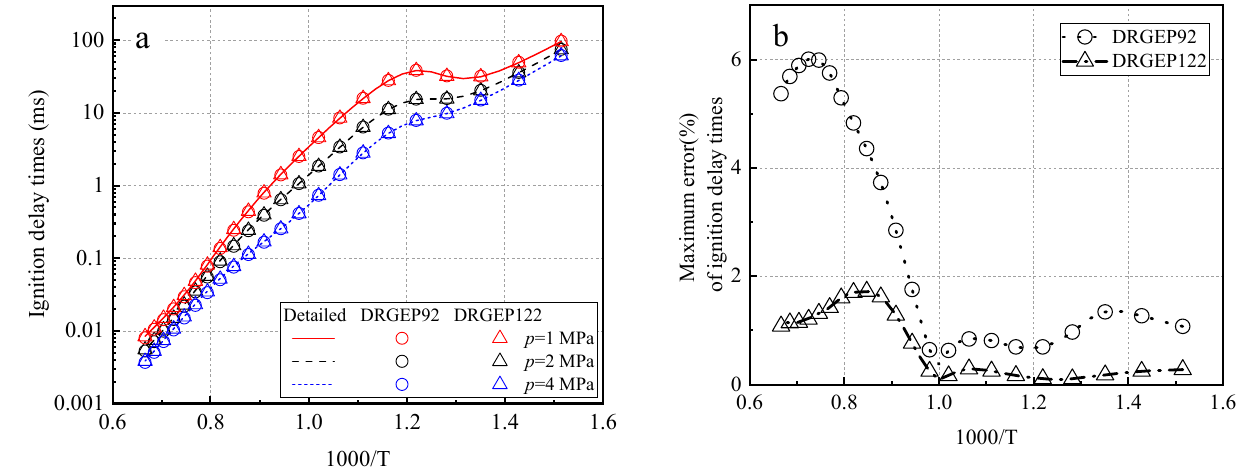
Figure 2. Detailed mechanism and comparison with two skeletal mechanisms (DRGEP92 and DRGEP122) to predict the ignition delay of CHX /air mixture. ( a ) Ignition delay times and ( b ) maximum error of ignition delay times.